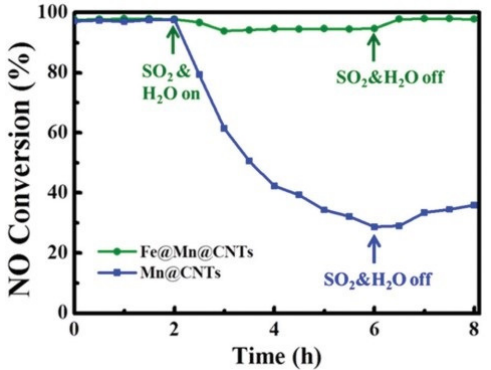
Figure 26. SO 2 + H 2 O tolerance test at 240 °C (Reaction conditions: [NH 3 ] = [NO] = 550 ppm, [O 2 ] = 5 vol %, [SO 2 ] = 100 ppm, [H 2 O] = 10 vol % (when used), N 2 as balance gas, GHSV=20,000 h − 1 ). (Reproduced with permission from Reference [49], Copyright 2016, The Royal Society of Chemistry.).